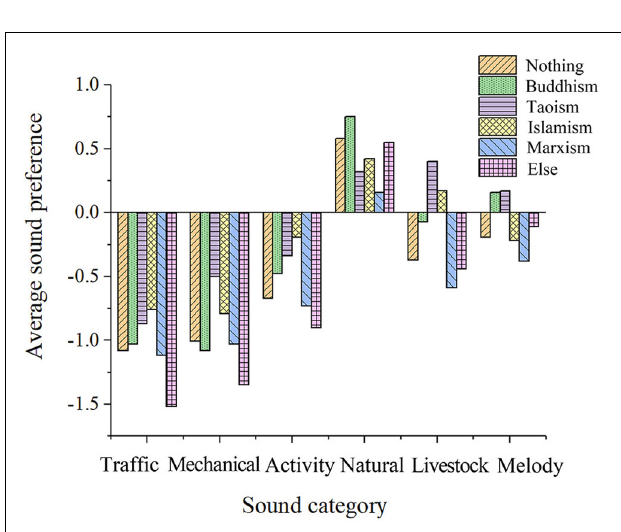
FIGURE 8 | Average soundscape preference of people of different beliefs.